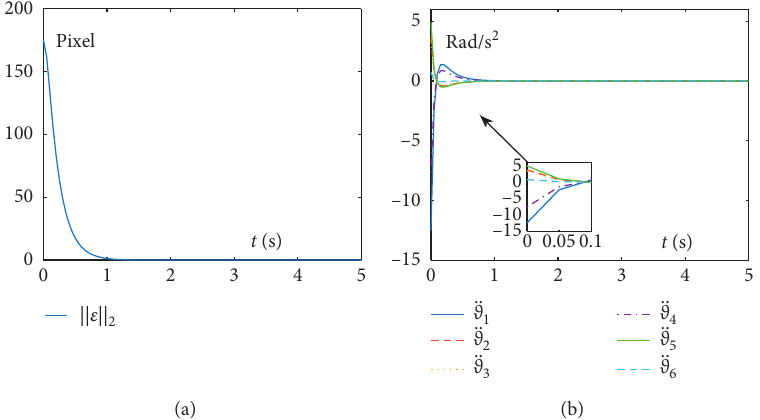
Figure 4: Simulation results on the PUMA 560 manipulator driven by the pseudoinverse method (38) for the visual servoing task with execution time T � 5s. (a) Time history of 2-norm of error ε . (b) Time history of joint